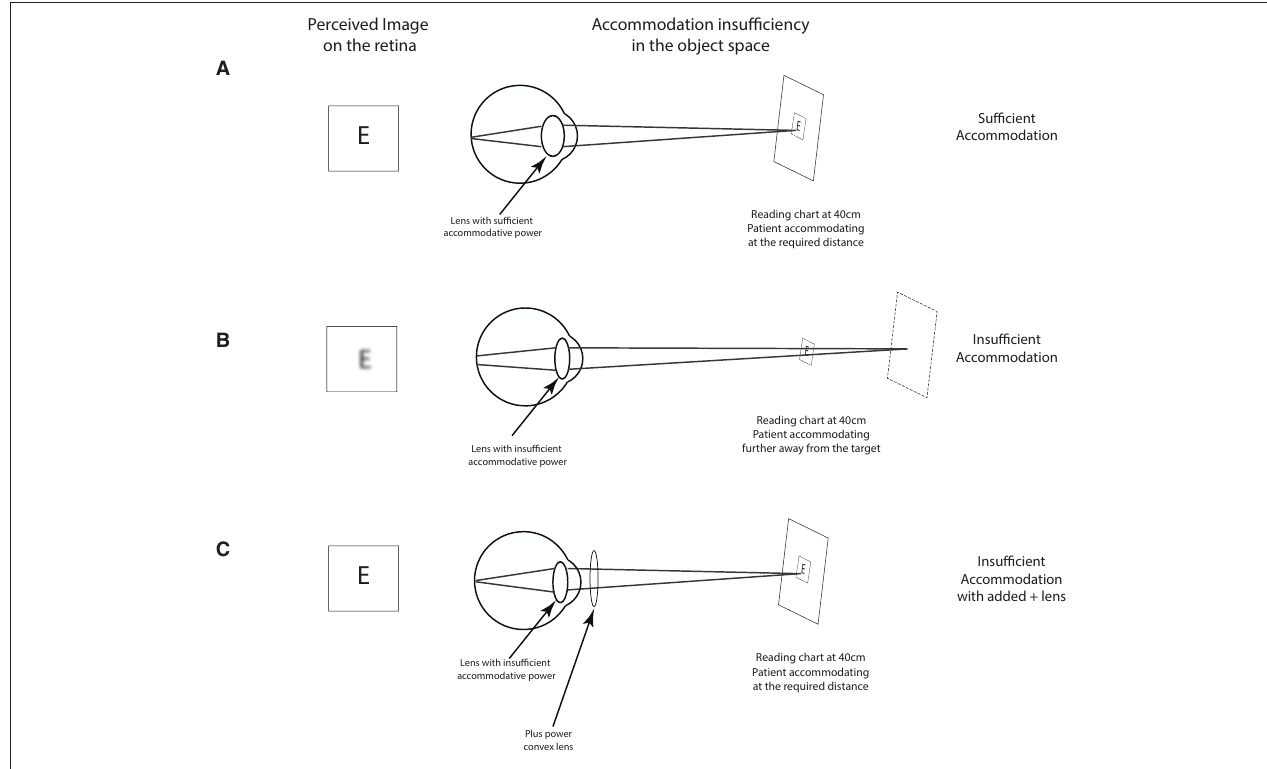
FIGURE 4 | Testing for accommodative insufficiency. Typically, a non-presbyopic patient (typically below 40 years of age) should have no problem accommodating on a reading target placed at 40cm (A) . In the presence of an accommodative insufficiency, the patient is unable to focus on the target and sees the reading blurry (B) .